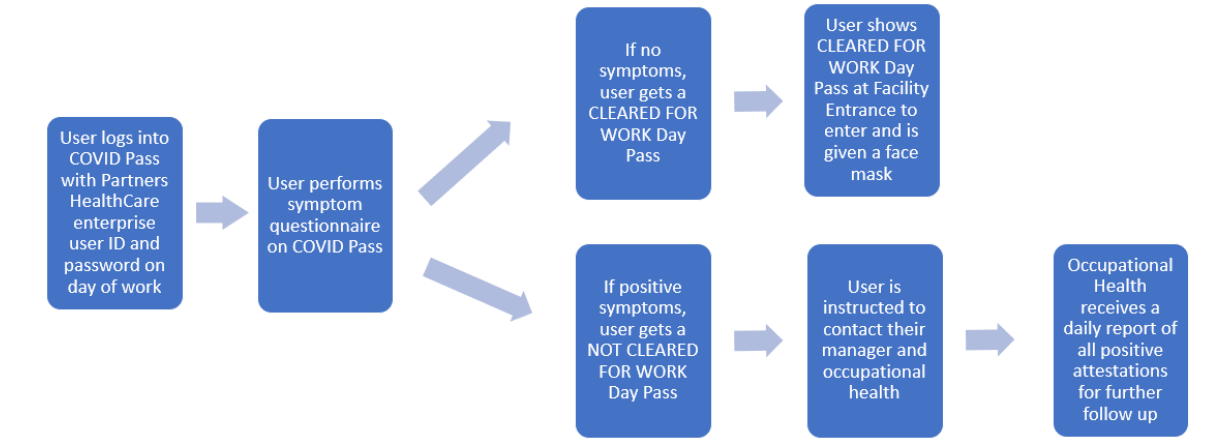
Figure 4. Schematic of the process and procedures involved in using the COVID Pass